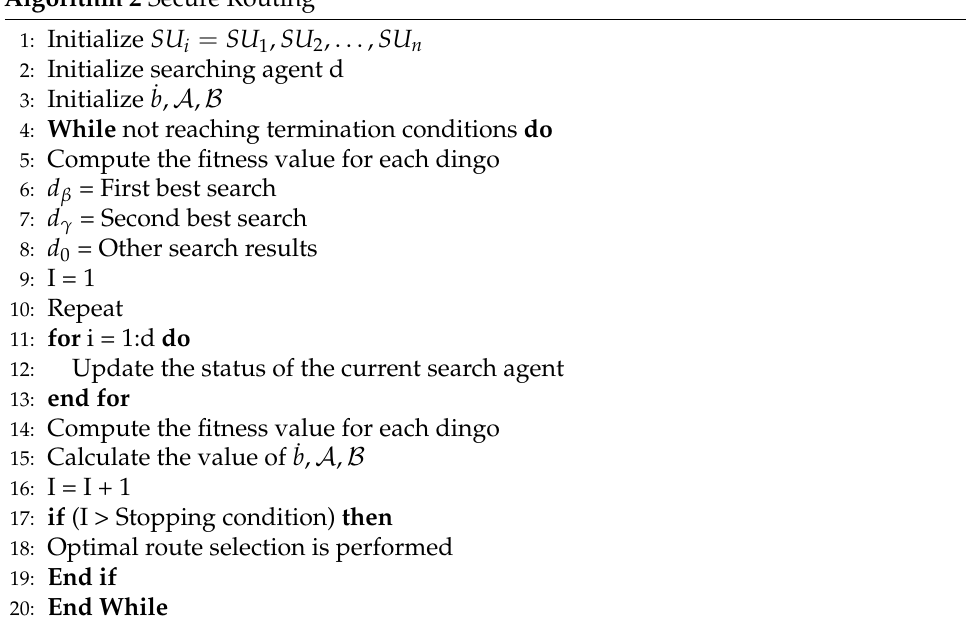
Algorithm 2 Secure